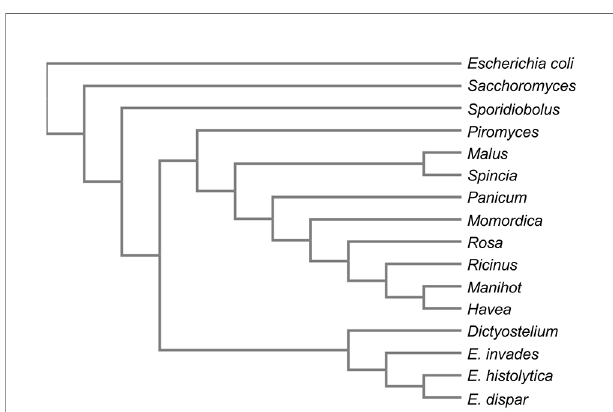
FIGURE 2 | Phylogram of aldose reductases. The aldose reductases sequences of E. histolytica , E. dispar , E. nuttalli were compared for homologous sequences using BlastP. The best scoring 10 proteins as well as three aldose reductase sequences used as outgroups were used to generate a phylogram using the online tool Clustal Omega (Sievers et al., 2011). Sequences used: E. histolytica aldose reductase (EHI_029620/EHI_039190), E. invadens aldo_ket_red domain-containing protein (EIN_497000), E. dispar NADPH-dependent alpha-keto amide reductase (EDI_260680), Piromyces fi nnis _aldehyde reductase_(ORX59359), Ricinus communis _NADPH- dependent aldo-keto reductase, chloroplastic_(XP_002529872), Manihot esculenta _NADPH-dependent aldo-keto reductase, chloroplastic-like_ (XP_021619253), Hevea brasiliensis _NADPH-dependent aldo-keto reductase, chloroplastic-like (XP_021670007), Momordica charantia _NADPH-dependent aldo-keto reductase, chloroplastic-like_(XP_022143954), Dictyostelium discoideum _aldehyde reductase_(XP_628918), Malus domestica NADPH- dependent aldo-keto reductase, chloroplastic-like (XP_008369945), Spinacia oleracea _NADPH-dependent aldo-keto reductase, chloroplastic-like (XP_021845528), Panicum hallii aldo-keto reductase family 4 member C10- like isoform X2 (XP_025809823), Rosa chinensis _NADPH-dependent aldo- keto reductase, chloroplastic-like (XP_024188589), Escherichia coli aldo-keto reductase (E0IVZ7), Saccharomyces cerevisiae NADPH-dependent aldose reductase (P38715), Sporidiobolus salmonicolor aldehyde reductase